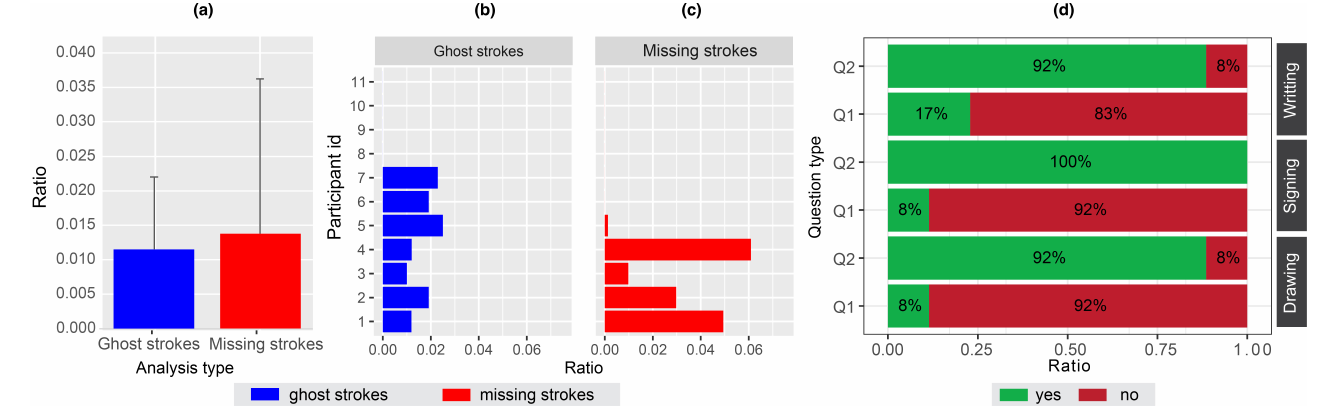
Figure 8. ( a ) Overall quantitative analysis for added and missing strokes. ( b ) Quantitative analysis of added strokes by participants. ( c ) Quantitative analysis of missing strokes by user. ( d ) User preference (Q1: Was it hard to write, sign or draw? Q2: Are you satisfied with the digital counterpart of your writing, signature, and